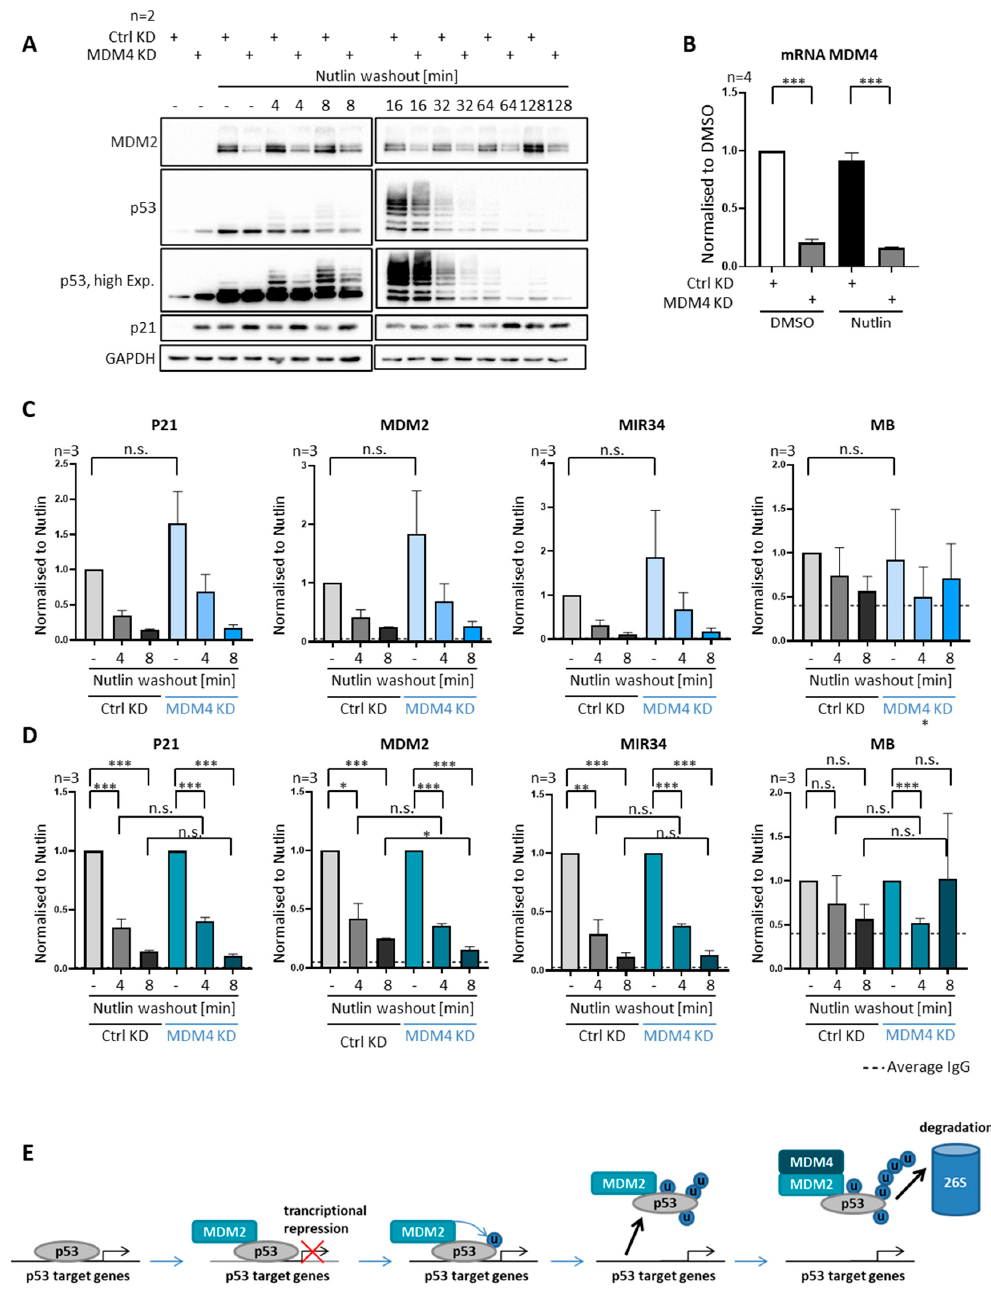
Figure 8. Efficient removal of p53 from promoters upon depletion of MDM4. ( A – D ) SJSA cells were transfected with siRNA against MDM4 48 h prior to Nutlin washout, or control transfected. ( A ) Depletion of MDM4 leads to the reduced ubiquitination of p53 and increased induction of p21 as visible by the analysis of a representative immunoblot. ( B ) Measurement of MDM4 mRNA shows an efficient MDM4 depletion by siRNA treatment. ( C ) ChIP analysis upon Nutlin washout, with or without MDM4 depletion. ( D ) The dissociation of p53 from promoters upon Nutlin washout was still significant and did not grossly differ regardless of MDM4 depletion. ( E ) Graphical summary of the proposed mechanism of MDM2-dependent p53 removal from cognate promoter sites. MDM2 associates with p53 and inhibits its transcriptional activity. MDM2-dependent ubiquitination of p53 is a necessary prerequisite for p53 removal from its target genes. Subsequently, the MDM2–MDM4 complex polyubiquitinates p53, followed by its proteasomal degradation. *** p < 0.001; ** p < 0.01; * p < 0.05; n.s., non-significant. “-“, no Nutlin washout.